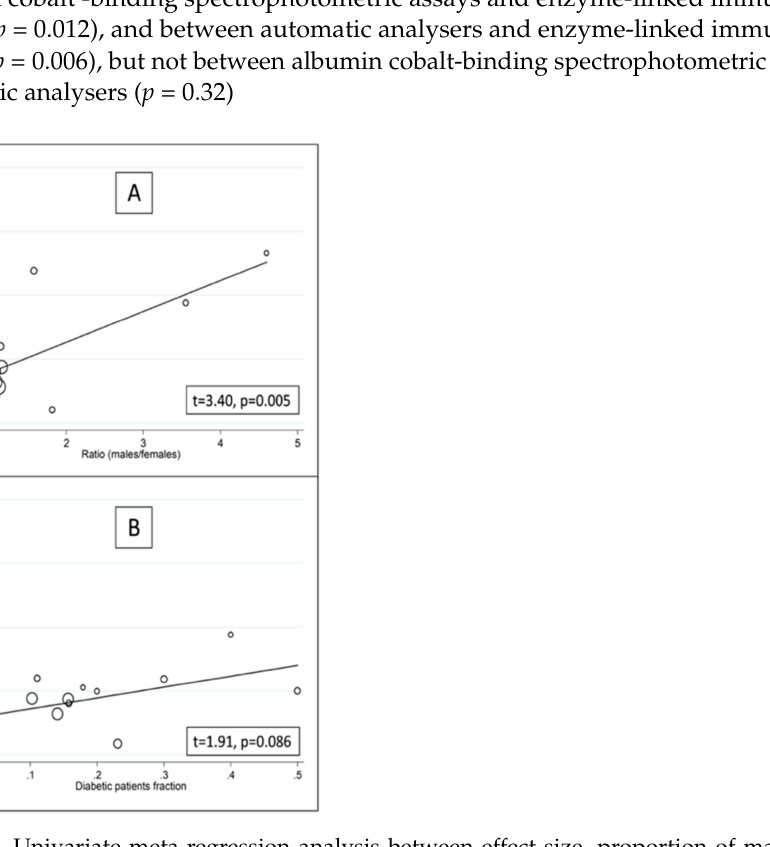
Figure 5. Univariate meta-regression analysis between effect size, proportion of males ( A ) and diabetes ( B ).